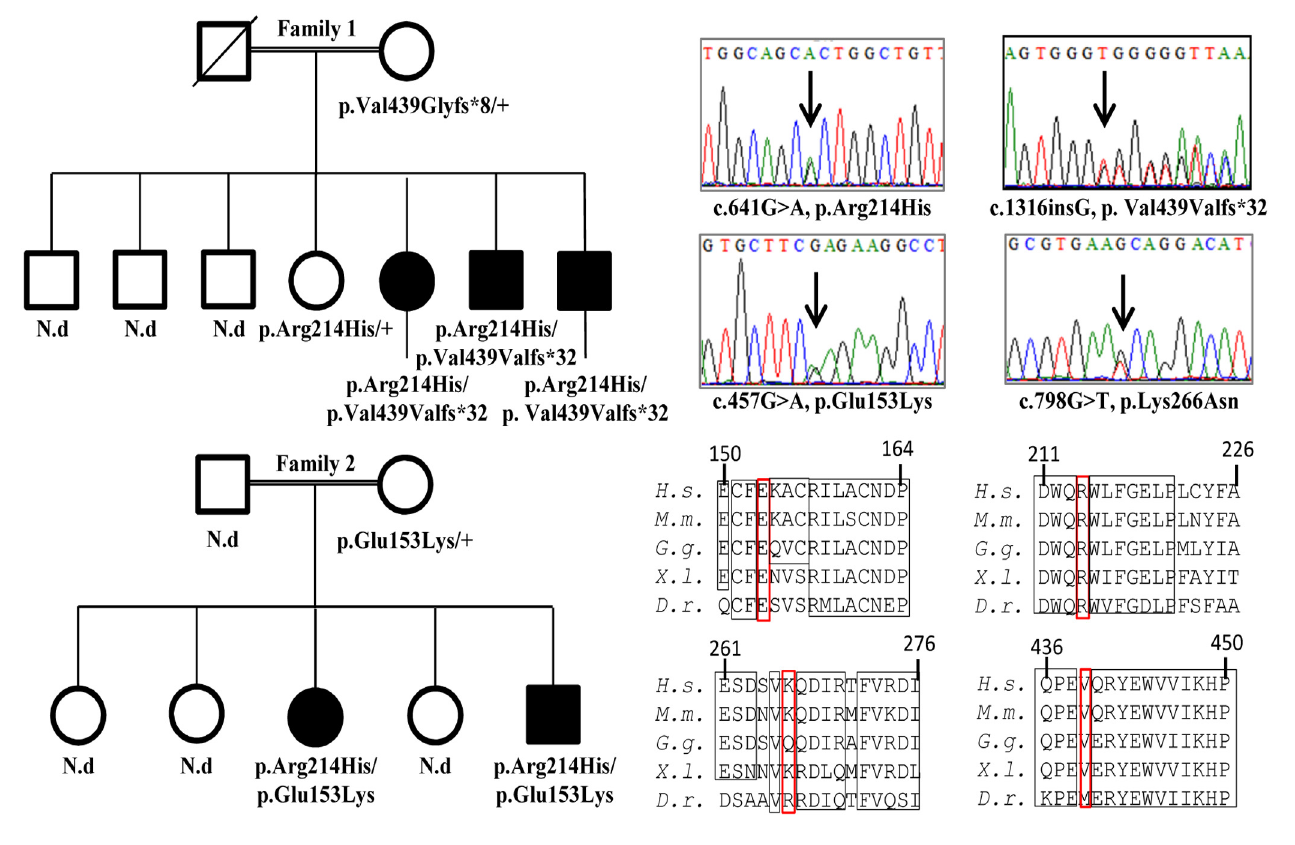
Fig 1. Mutations in TBC1D24 segregate with non-syndromic hearing loss. (A) Pedigrees of the two families are shown with the segregation of the mutations identified in TBC1D24 . (B) Electrophoregrams showing the 4 heterozygote mutations identified in this work. C) Alignments of TBC1D24 sequences around the 4 mutated amino acids highlighted by red rectangles ( H . s .: Homo sapiens ; M . m .: Mus musculus ; G . g .: Gallus gallus ; X.l.: Xenopus laevis ; D.r.: Danio rerio ).